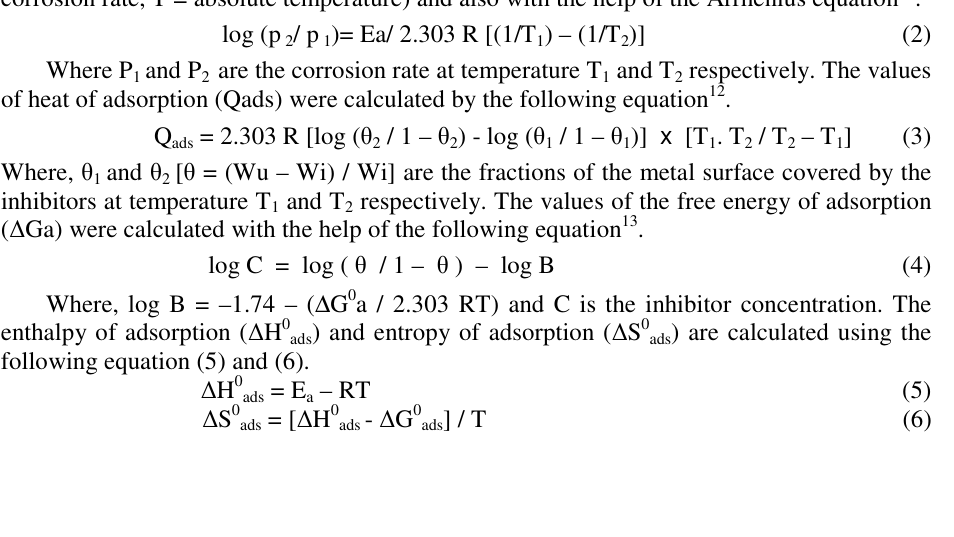
+ 0.05 N H SO ) and (0.1 N HNO 3 2 4